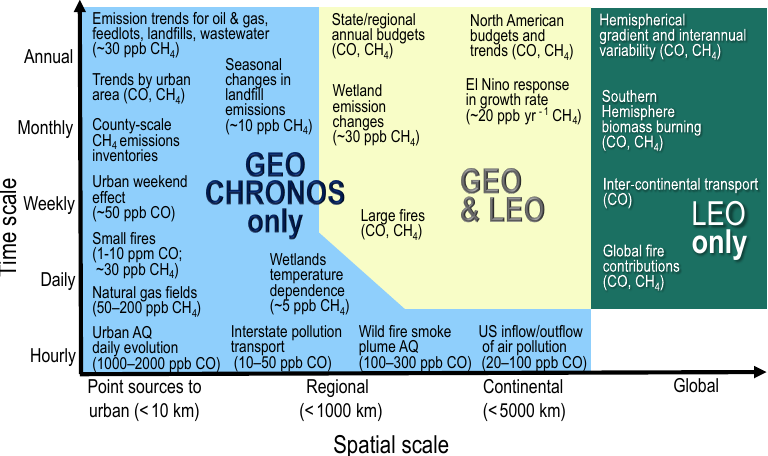
Figure 2. CHRONOS’ sub-hourly observations would provide access to the fine temporal and fine spatial scales of CH 4 and CO processes for understanding the emissions and transport of air pollution for air quality, climate and energy management applications. Estimated abundances are for process contributions above background